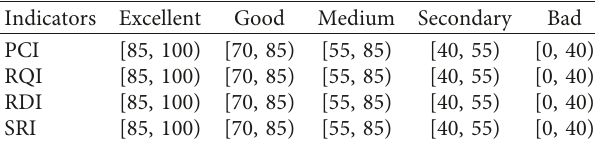
Figure 6: SSI comparison in 2015 and 2016. Table 1: Road surface